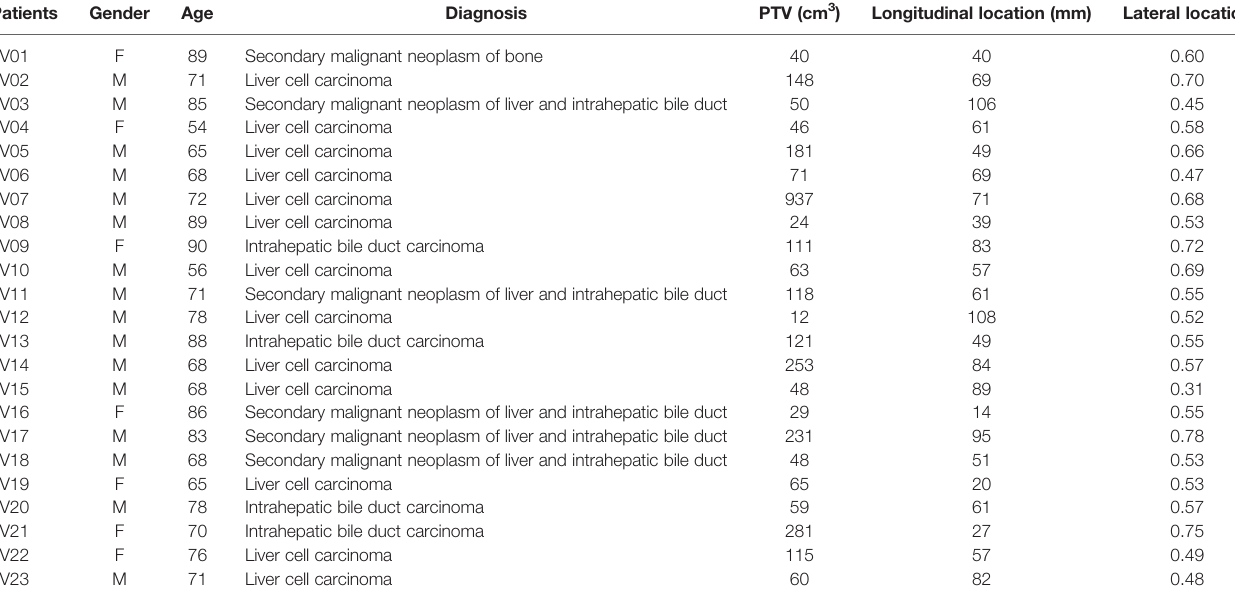
TABLE 1 | List of patients with planning target volume (PTV) size and average longitudinal and lateral locations. Patients